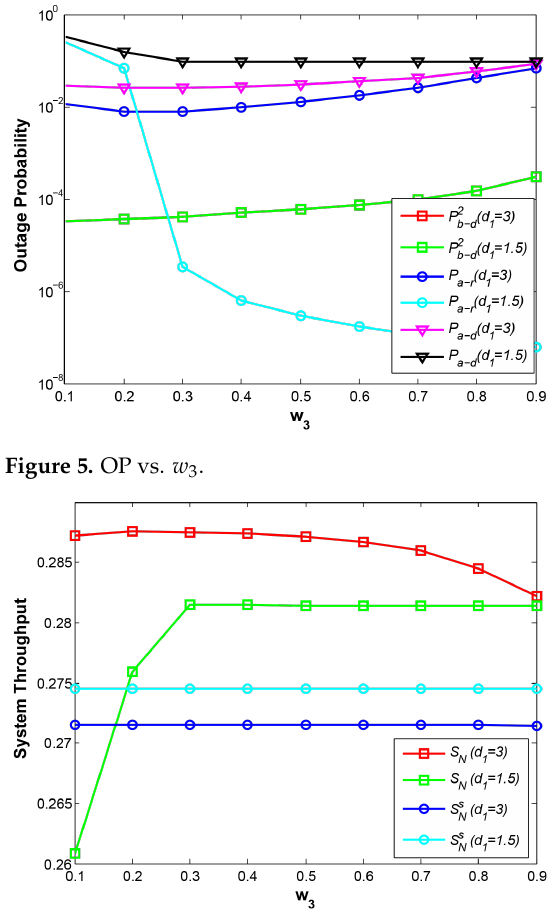
Figure 6. System throughput vs. w 3